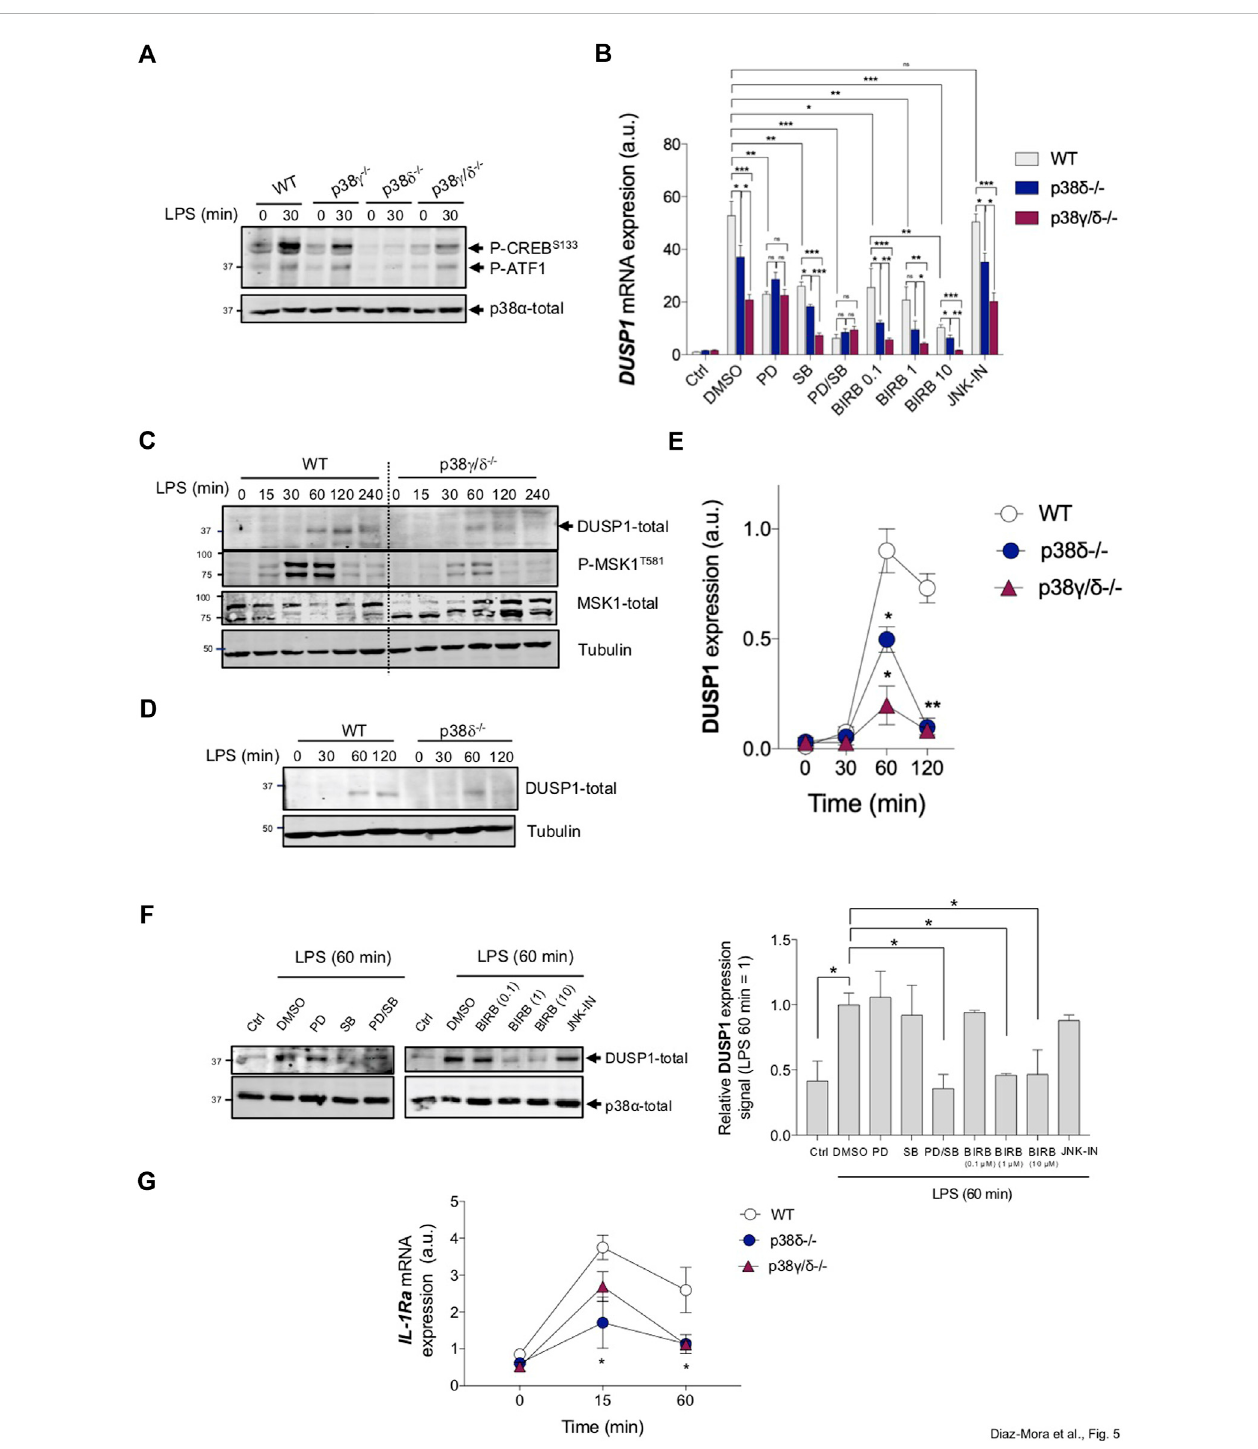
FIGURE 5 Deletionofp38 δ impairstheactivationofMSK1downstreamtargets. (A) BMDMfromWT,p38 γ − / − ,p38 δ − / − orp38 γ / δ − / − micewerestimulatedwith100 ng/ mL LPS for 30 min. Cell lysates were immunoblotted with the indicated antibodies. Phospho-CREB (Ser133) antibody also recognises phosphorylated ATF1. Representative immunoblots from three independent experiments in duplicate are shown. (B) WT, p38 δ − / − or p38 γ / δ − / − BMDM were exposed to 100 ng/mL LPS for 1 h with or without 2 µM PD184352, 10 μ M SB203580, 3 µM JNK-IN-8 (to inhibit JNKs) or 0.1 µM (to inhibit p38 α / β ), 1 µM (to inhibit p38 α / β and p38 γ ) or 10 µM (to inhibit p38 α / β , p38 γ and p38 δ ) BIRB0796 and then stimulated with LPS. Relative mRNA expression was determined by qPCR for DUSP1. Results were normalized to β -actin mRNA expression and x-fold induction was calculated relative to WT expression at 0 h control. Data show mean ± SEM from one representative experiment of three in triplicate, with similar results. * p ≤ 0.05, ** p ≤ 0.001. (C,D) BMDM from WT, p38 γ / δ − / − or p38 δ − / − mice were stimulated with 100 ng/mL LPS for the indicated times. Cell lysates were immunoblotted with the indicated antibodies. Representative immunoblots from three independent experiments in duplicate are shown. (E) DUSP1 bands from blots shown in panels (C,D) were quanti fi ed and data represented in arbitrary units(a.u.)asmean±SEMfromthreeexperimentsinduplicate.* p ≤ 0.05;** p ≤ 0.001relativetoWT. (F) WTBMDMwereincubatedfor1 hwithorwithout2 µM PD184352, 10 μ M SB203580, 3 µM JNK-IN-8 or 0.1, 1 or 10 µM BIRB0796 and then stimulated with LPS. Cell lysates were immunoblotted with the